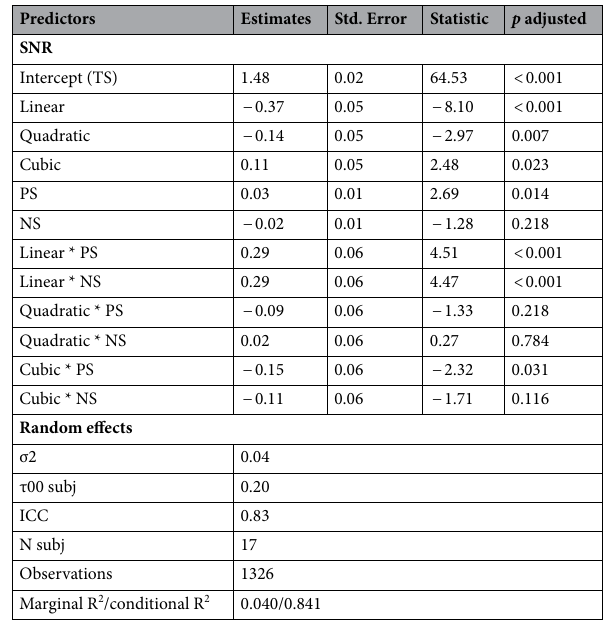
Table 3. Model parameters of the inter-modulation analyses. Factors were dummy coded with truly suffixed as reference level, using polynomial interpolation. Note that the b -coefficient (Estimates) represents the adjustment with respect to the reference level. TS truly suffixed, PS pseudo-suffixed, NS non-suffixed.